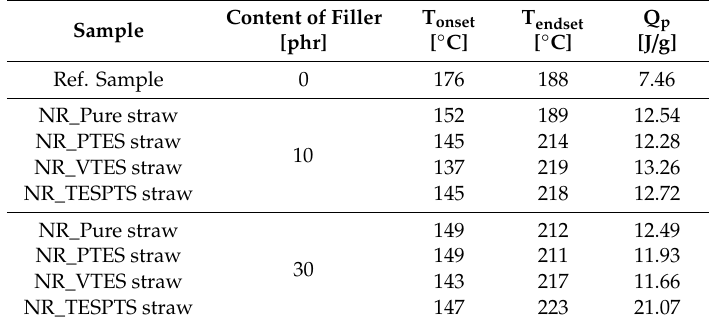
Table 3. Vulcanization kinetics parameters of rubber mixtures obtained on the basis of di ff erential scanning calorimetry (DSC)